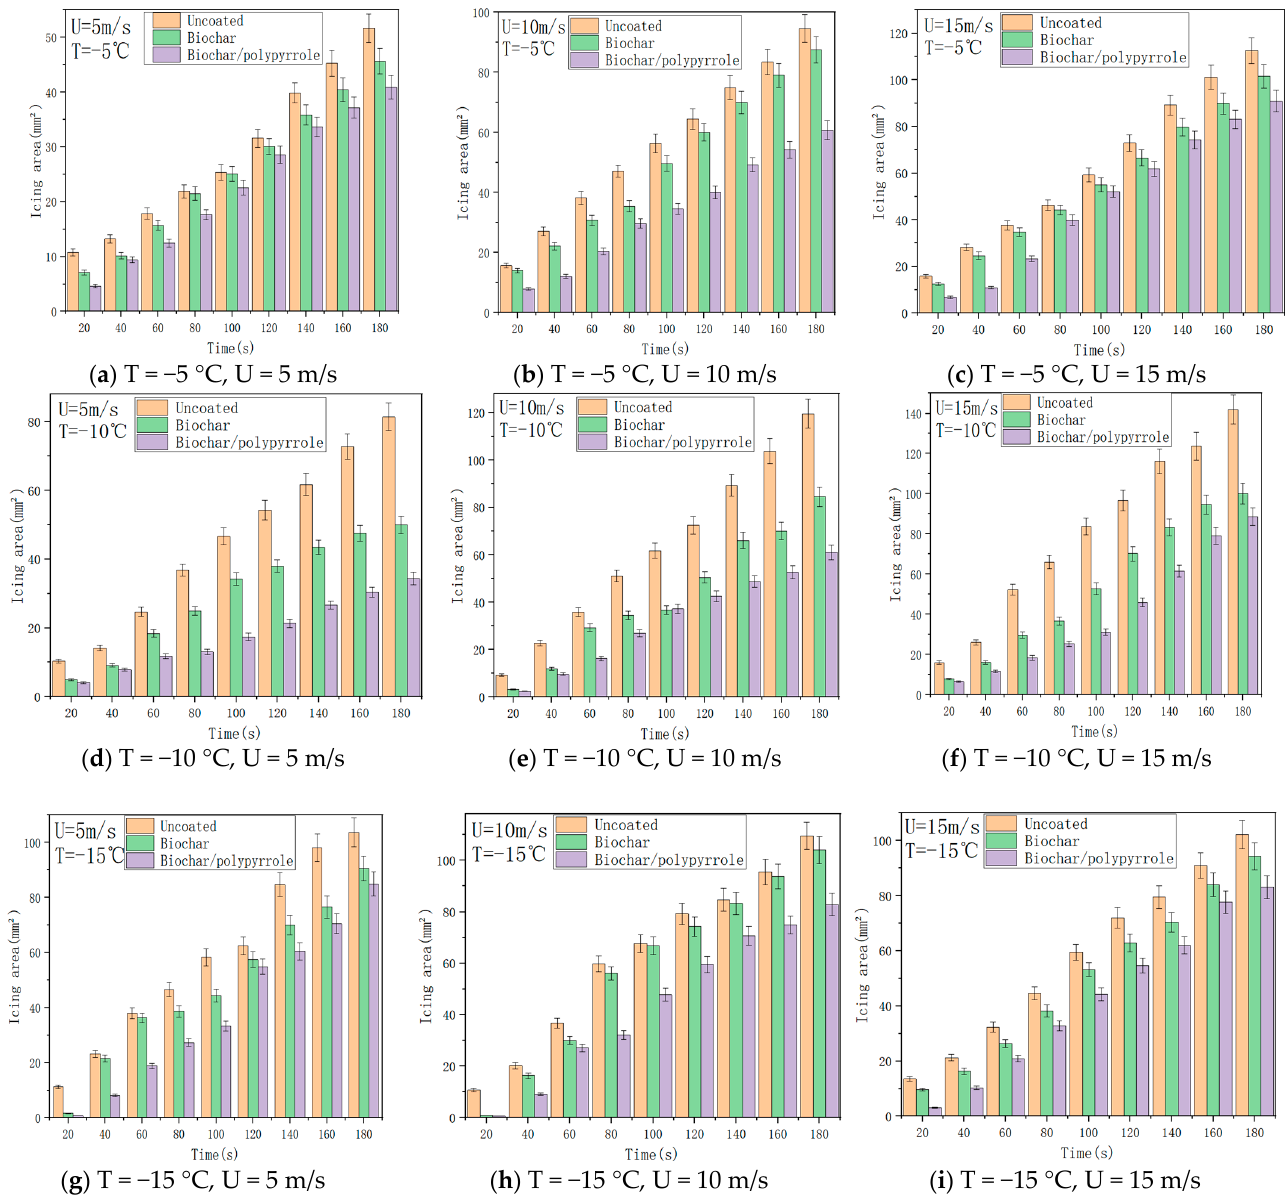
Figure 9. Icing area of uncoated coating, biochar coating, and biochar/polypyrrole coating. Table 6. The maximum ice coverage area of uncoated, biochar, and biochar/polypyrrole.